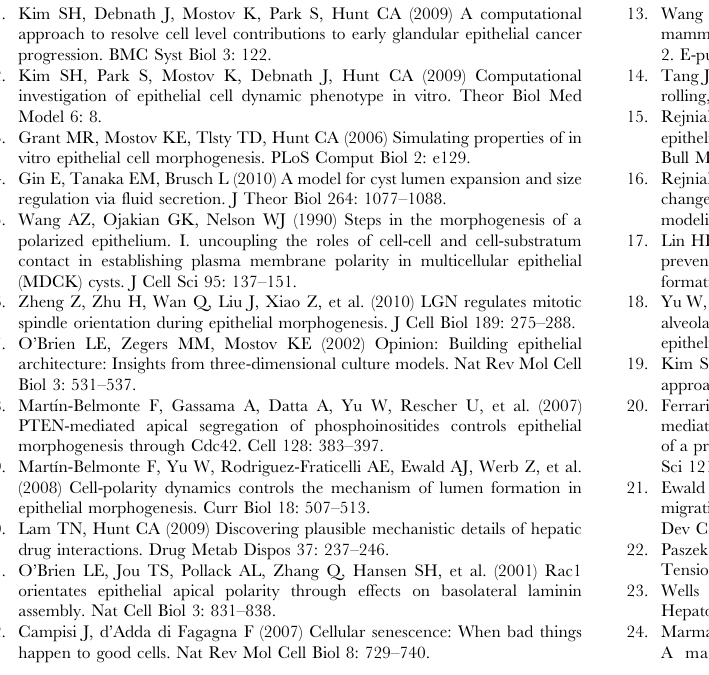
Table S2 Sources of stochasticity within ISMAs. The listed events or variable assignments provide behavior variability during CYSTOGENESIS . Note that index changes, which are random, contribute to many CELL level events, including shape change and LUMEN expansion.